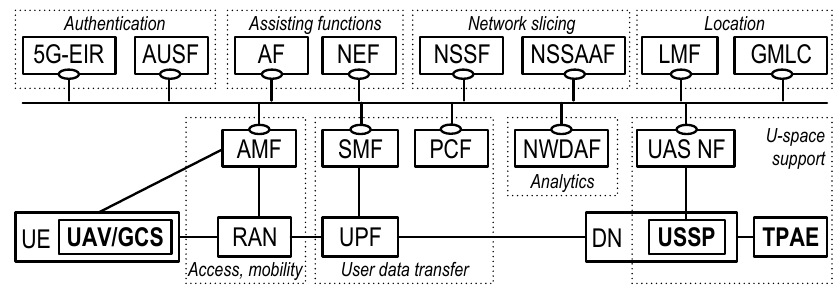
Figure 3. Integrated U-space and 5GS ecosystems based on